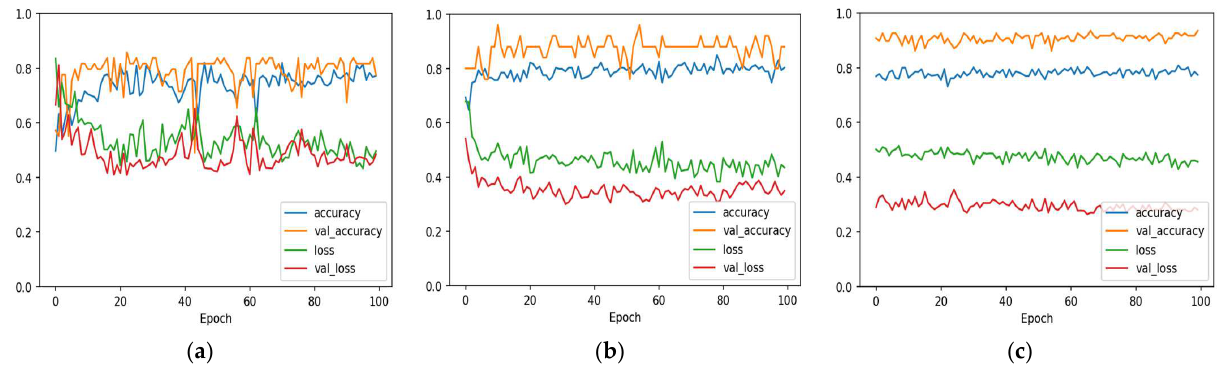
Figure 8. Bi-LSTM model accuracy and loss with epochs. ( a ) Cleveland dataset; ( b ) Statlog dataset; ( c ) Comprehensive dataset.